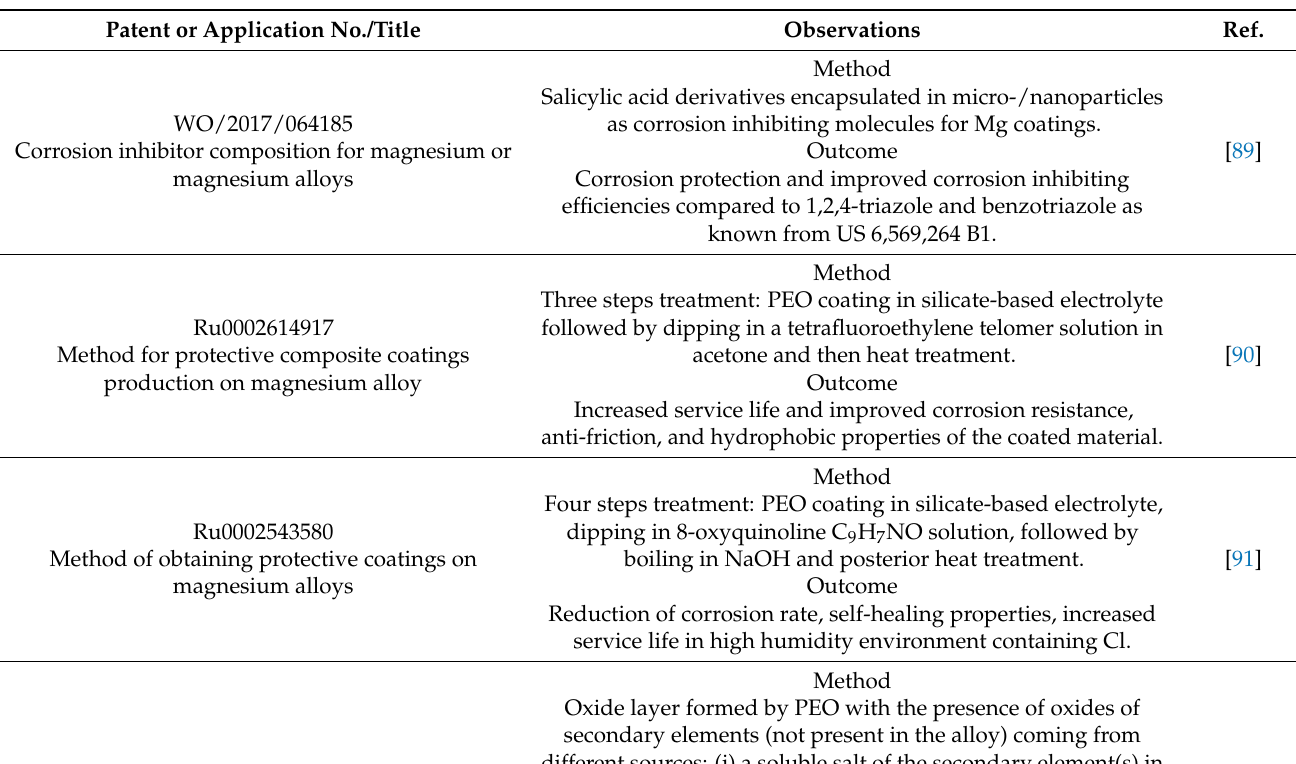
Table 2. PEO patent